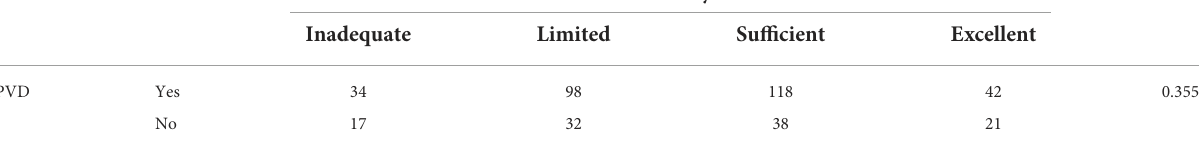
TABLE 5 The distribution between overall health literacy levels (MMHLQ) with